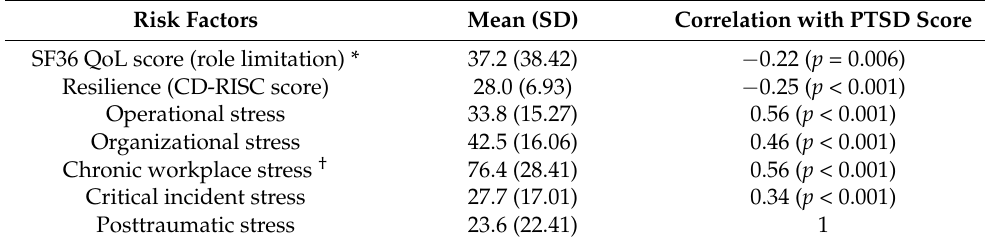
Table 5. Occupational and environmental risk factors for PTSD (Univariate and Bivariate